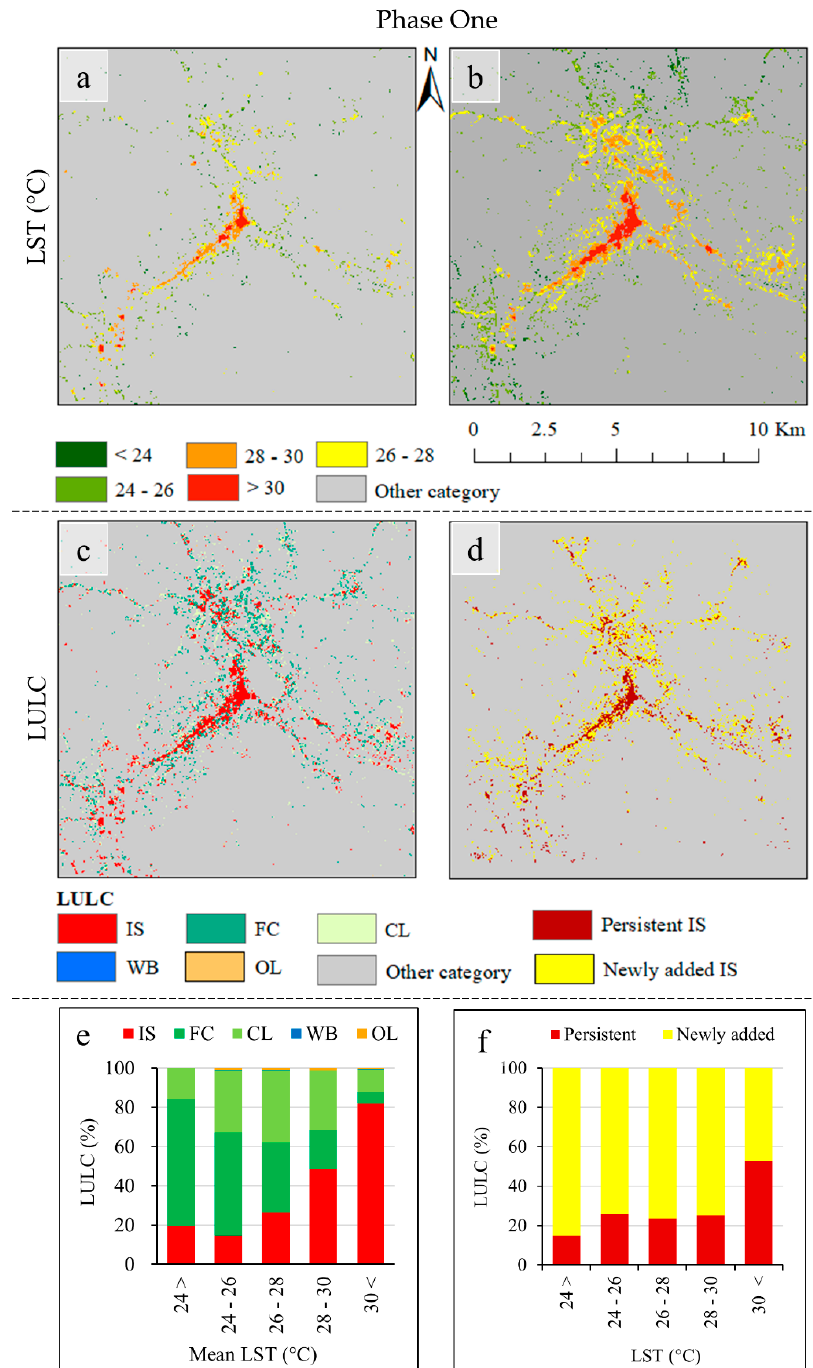
Figure 5. LST spatial and temporal pattern over the LULC in Phase One: ( a ) LST over IS area in 1996; ( b ) LST over IS area in 2006; ( c ) persistent and newly added IS in 2006 (newly added IS represented with respective LULC in 1996); ( d ) persistent IS and newly added IS in 2006; ( e ) fraction of LULC in 2006 (with respect to Figure 5c) as a percentage by LST classes; ( f ) fraction of persistent and newly added IS in 2006 (with respect to Figure 5d) as a percentage by LST classes. Note: The other category in the legend shows no impervious surface that was not accounted for in this calculation.